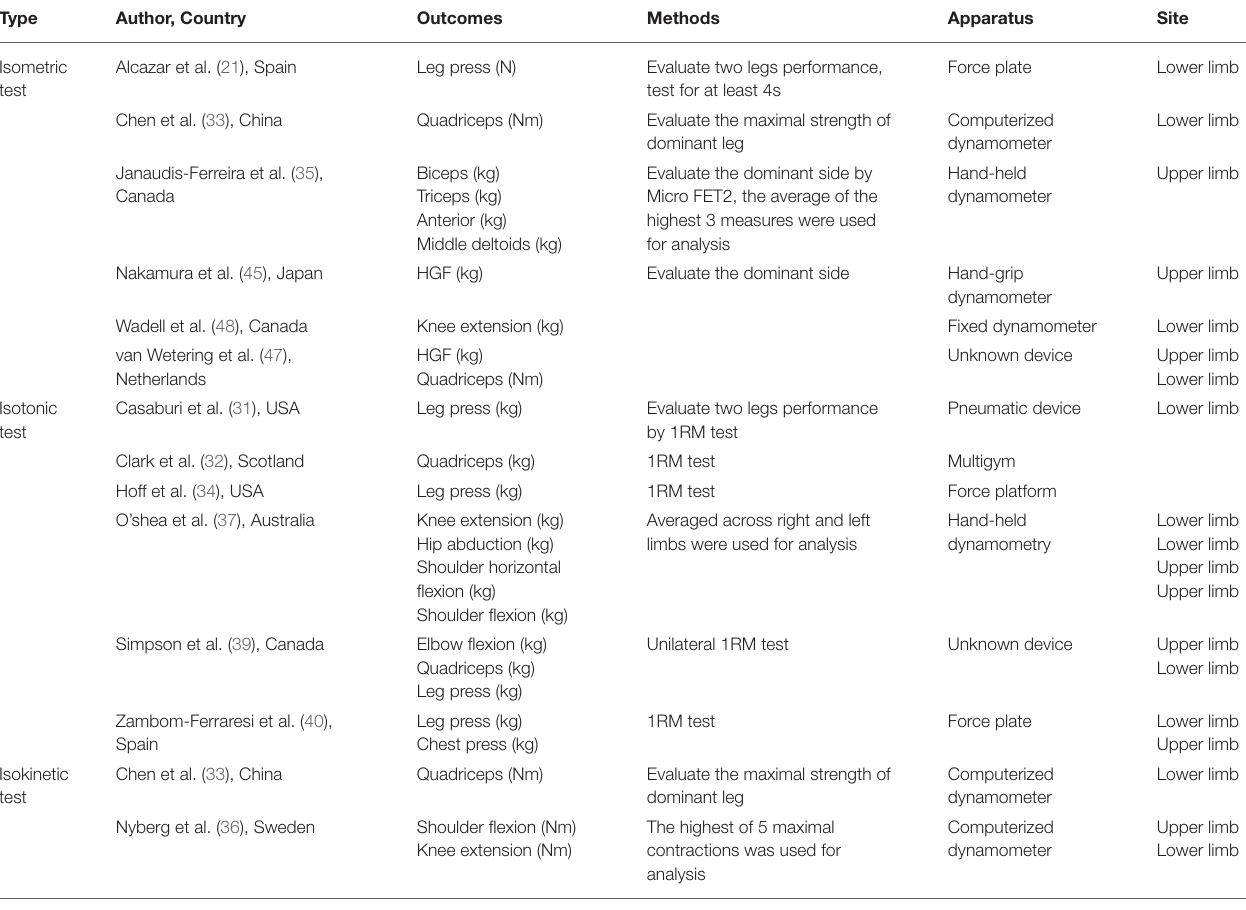
TABLE 3 | Characteristics of skeletal muscle strength tests.